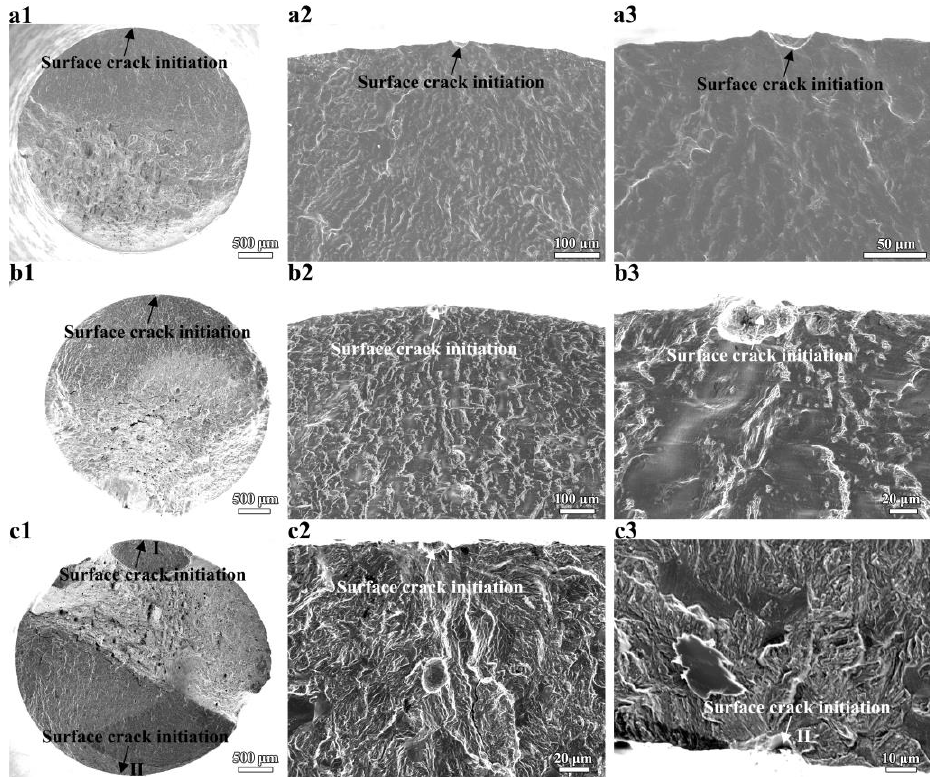
Figure 8. Fatigue fracture surfaces of 30CrMoSiA specimens in the initial state and after NA-8800: ( a1 – a3 ) Initial specimen failed from single-site crack initiation: 𝜎 𝑎 = 580 MPa, N f = 1.8 × 10 5 cycles; ( a2 , a3 ) are enlarged views of the crack initiation site. ( b1 – b3 ) Specimen after NA-8800 failed from single-site crack initiation: 𝜎 𝑎 = 580 MPa, N f = 1.4 × 10 5 cycles; ( b2 , b3 ) are enlarged views of the crack initiation site. ( c1 – c3 ) Specimen after NA-8800 failed from multi-site crack initiation: 𝜎 𝑎 = 580 MPa,